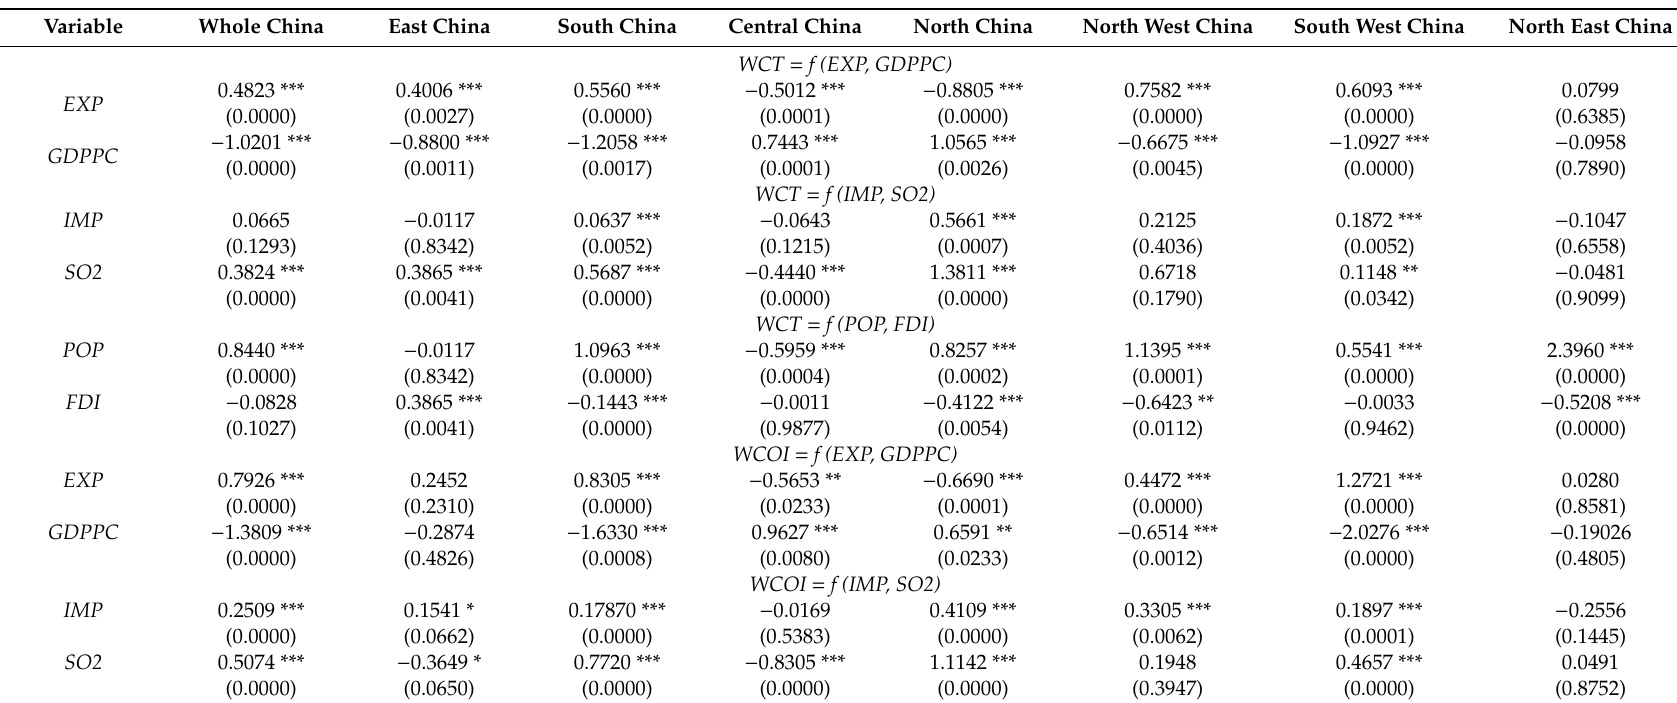
Table 7. Fully modified ordinary least squares (FM-OLS) estimates and the long-run elasticities for the whole of China and all regions.